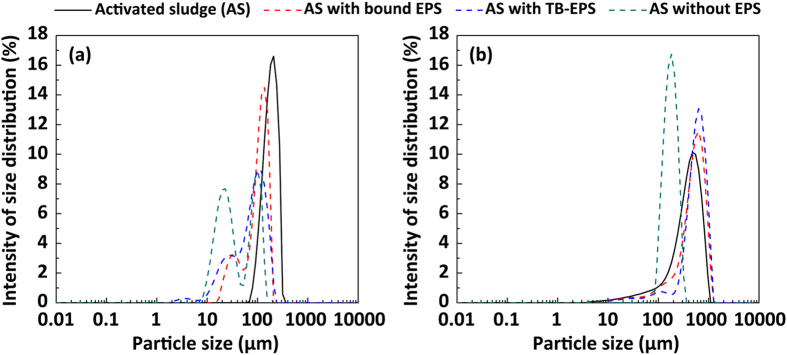
Roles of various fractions of soluble extracellular polymeric substances (EPS) in the sludge aggregation process, reflected by changes in the size distribution profiles of the activated sludge particles, whose diameters were determined by small-angle laser light scattering, before (a) and after (b) the expected aggregation.